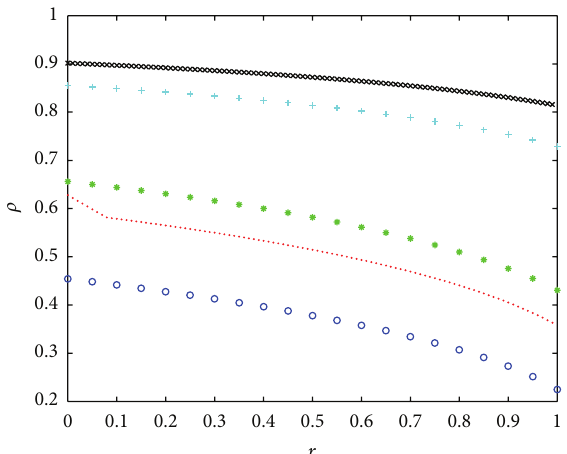
Figure 1: The relation between 𝜔 and 𝜌 , when 𝑁 = 100 , 𝜔 = 0.6